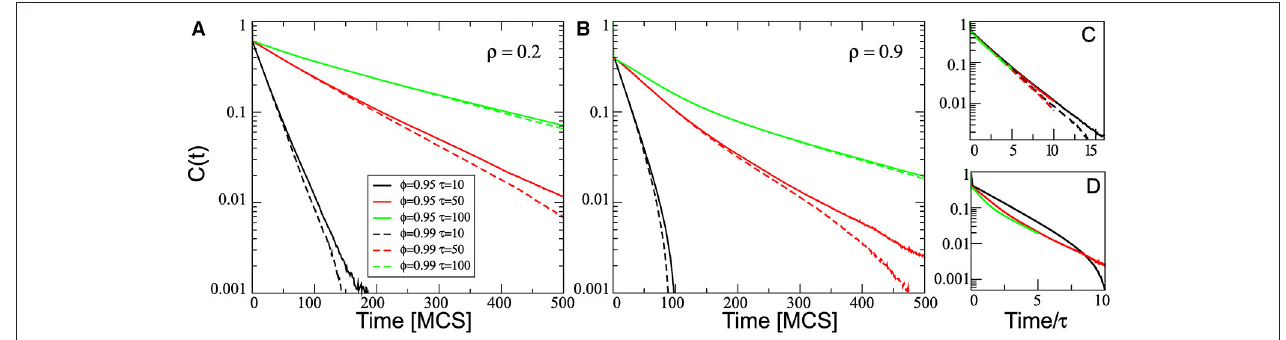
FIGURE 5 | Semi-log plot of the temporal autocorrelation function C ( t ) averaged over all cells in the simulation. The plots correspond to three different values of τ , two values of φ (0.95 solid lines and 0.99 dashed lines) and for two different densities: ρ = 0.2 (A) and ρ = 0.9 (B) . (C,D) Shows the collapse of the curves by rescaling the horizontal axes by τ , for the simulations at low and high density, respectively. All other parameters values are the same as in Figure 2 .